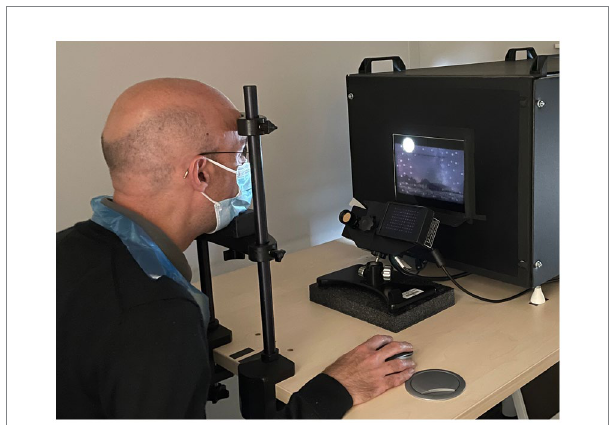
FIGURE 6 Participant viewing the HDR display and using a mouse to respond to the task. The eye tracker can be seen between the participant and the display. Room lighting was switched off during the experiment. The participant consented to use of their image in this